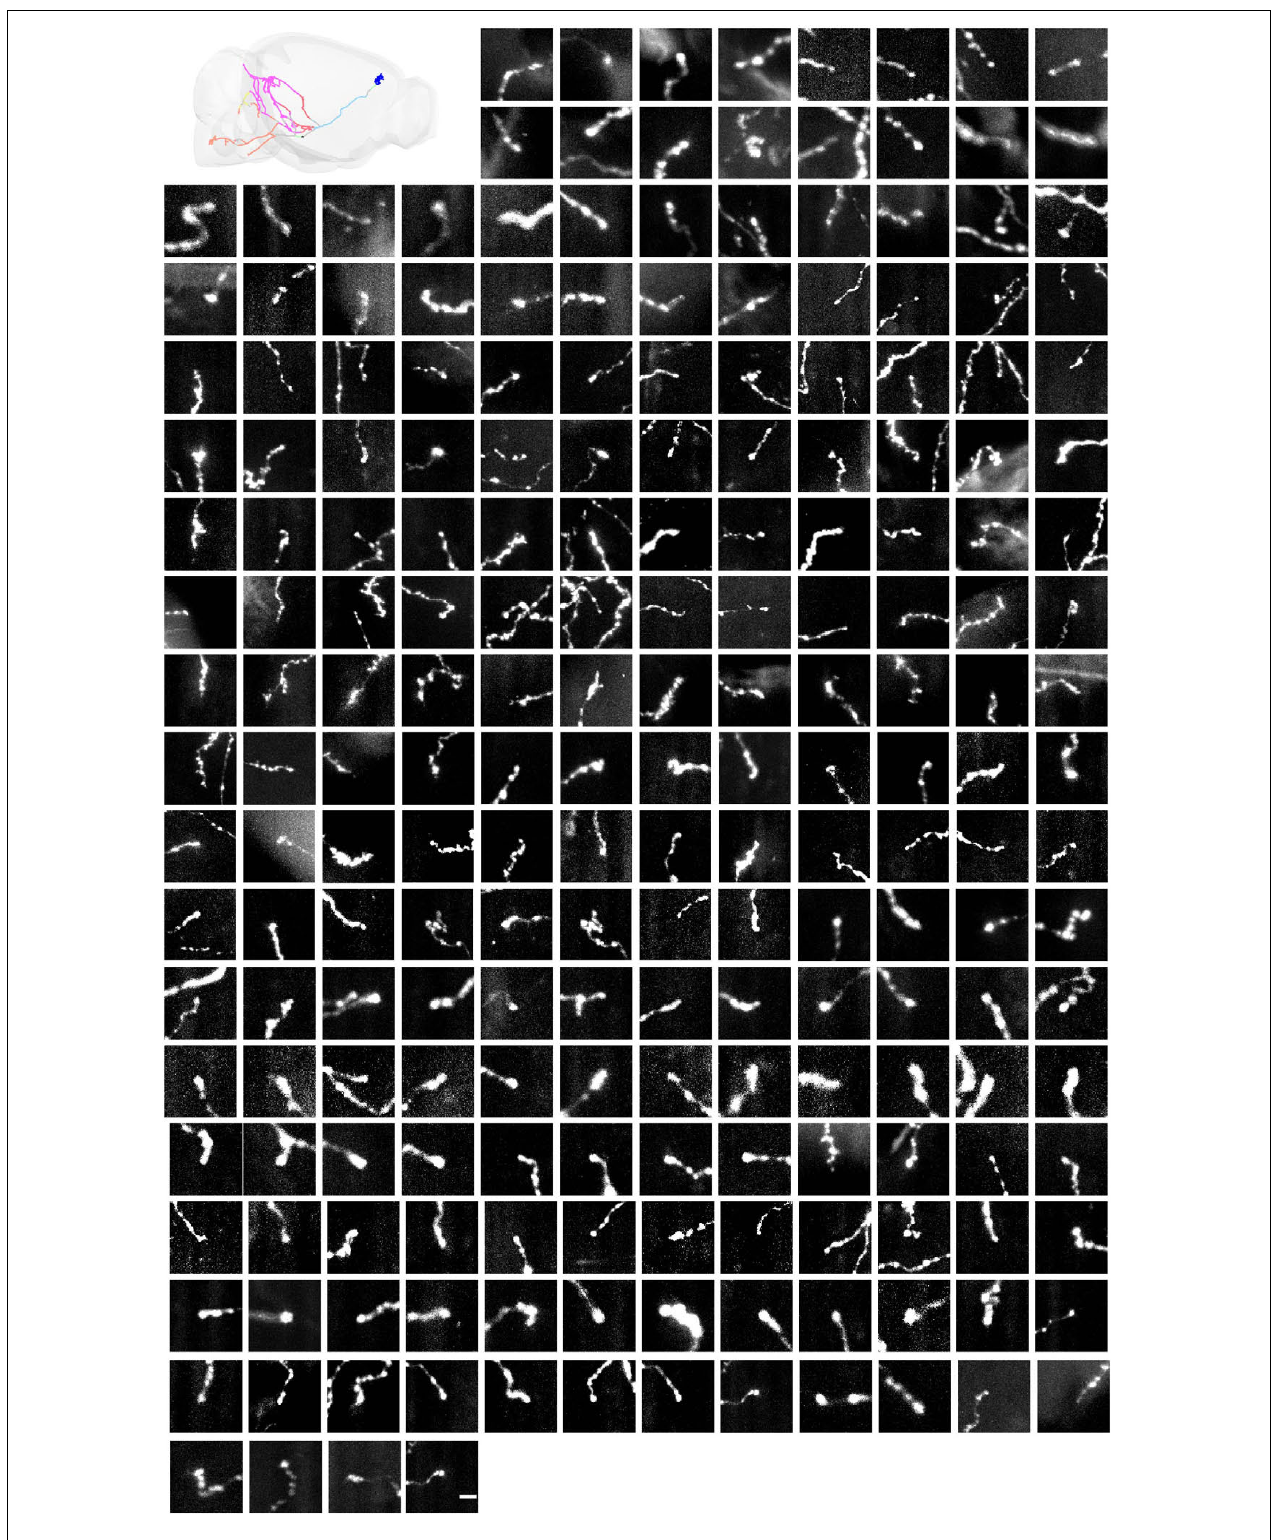
FIGURE 12 | All axonal terminals of one mPFC neuron. Maximum intensity projection (raw coronal images) of all the axonal terminals ( n = 212) belonging to the mPFC neuron. Axons in different brain areas are color coded (same scheme as in Figure 9A ). Scale bar, 5 µ m.